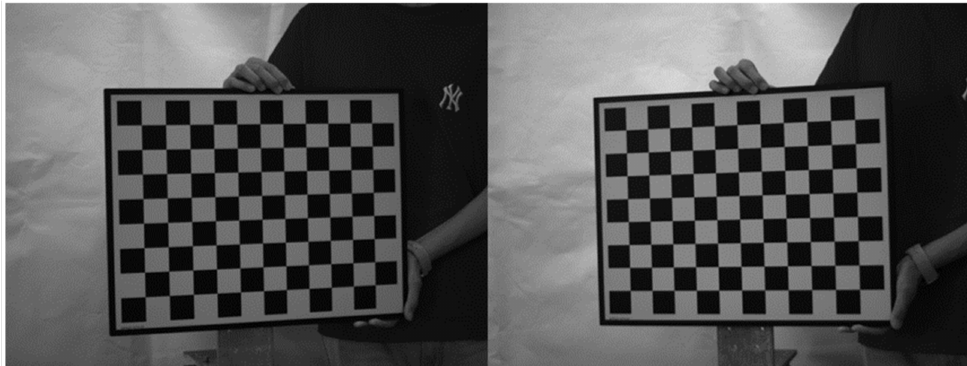
Figure 11. Checkerboard calibration plate in the